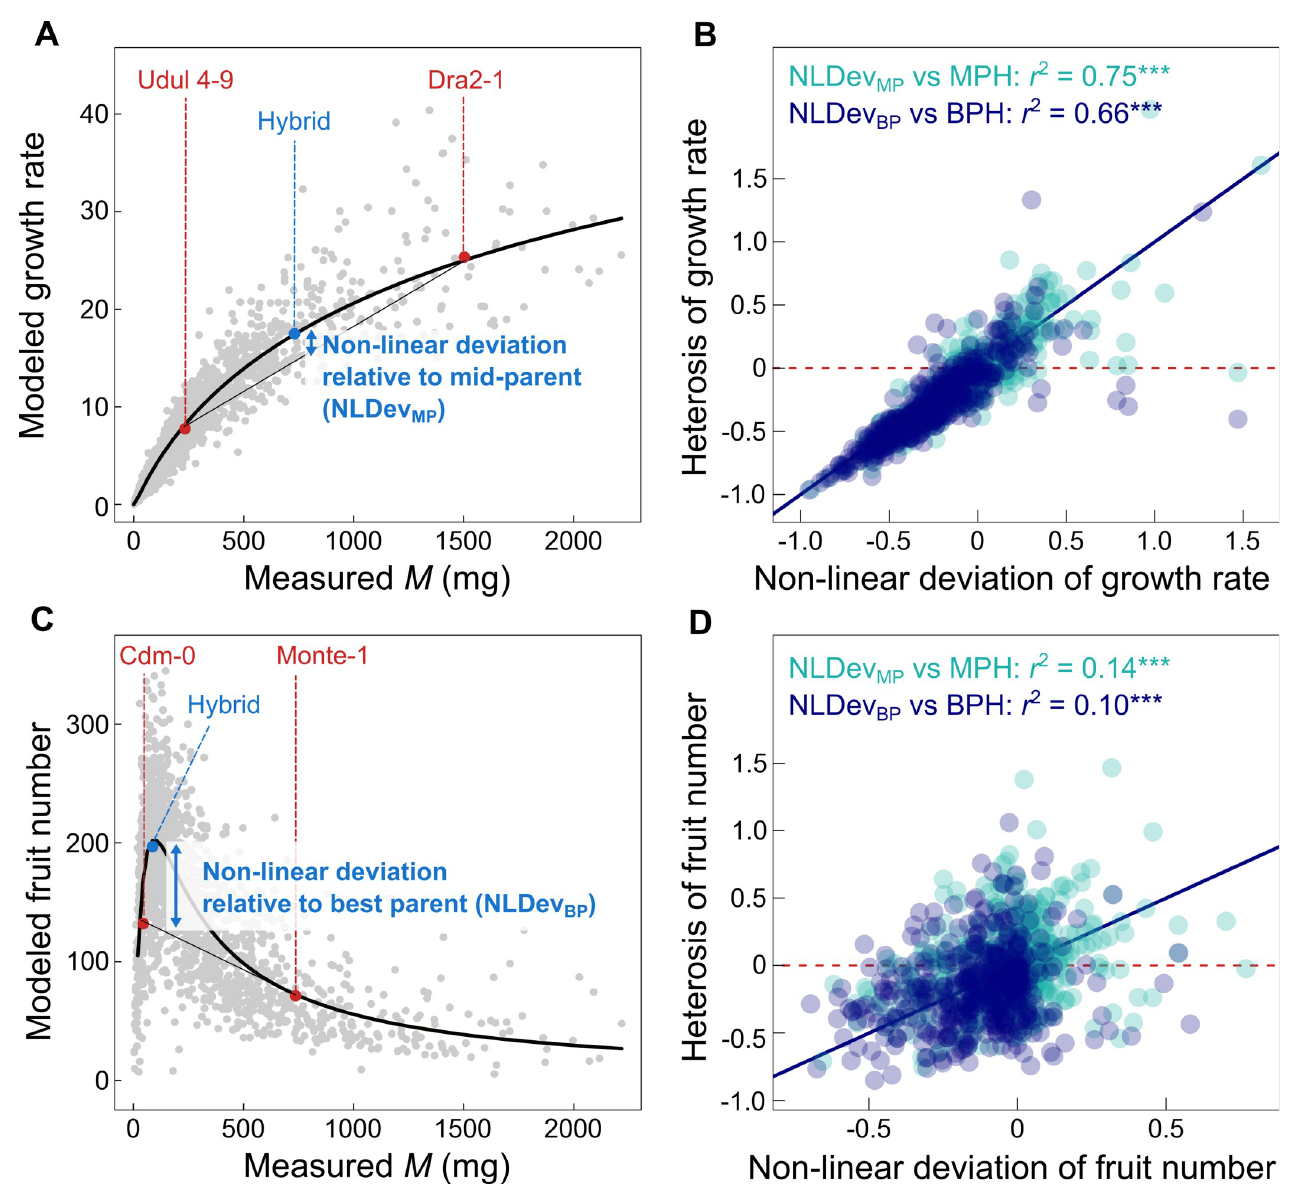
Fig 7. Prediction of heterosis with phenotypic nonlinearity. (A) Allometric relationship of growth rate ( g [ M ], black solid line) fitted in accessions, with an example of two parental accessions (Udul 4–9 and Dra2-1, in red) and their hybrid (in blue). NLDev (blue arrows) was calculated relative to mid-parent value (MP pred ): NLDev MP = ( g [ M 1 x 2 ] − MP pred ) / MP pred and relative to best-parent value (BP pred ): NLDev BP = ( g [ M 1 x 2 ] − BP pred ) / BP pred . (B) Correlation between NLDev and heterosis in all hybrids ( n = 447), both relative to MPH (light blue) and BPH (dark blue). (C) Allometric relationship of fruit number ( f [ M ], black solid line) fitted in accessions, with an example of two parental accessions (Cdm-0 and Monte-1, in red) and their hybrid (in blue). NLDev was calculated relative to mid-parent value (NLDev MP ) and relative to best-parent value (NLDev BP ). (D) Correlation between NLDev and heterosis in all hybrids ( n = 447), both relative to MPH (light blue) and BPH (dark blue). Red dashed lines represent zero axes. Black dashed line represents 1:1 line. Grey dots are all hybrid individuals. r 2 are Pearson’s coefficients of correlation ( ��� P < 0.001). BPH, best-parent heterosis; MPH, mid-parent heterosis; NLDev, nonlinear deviation; NS,